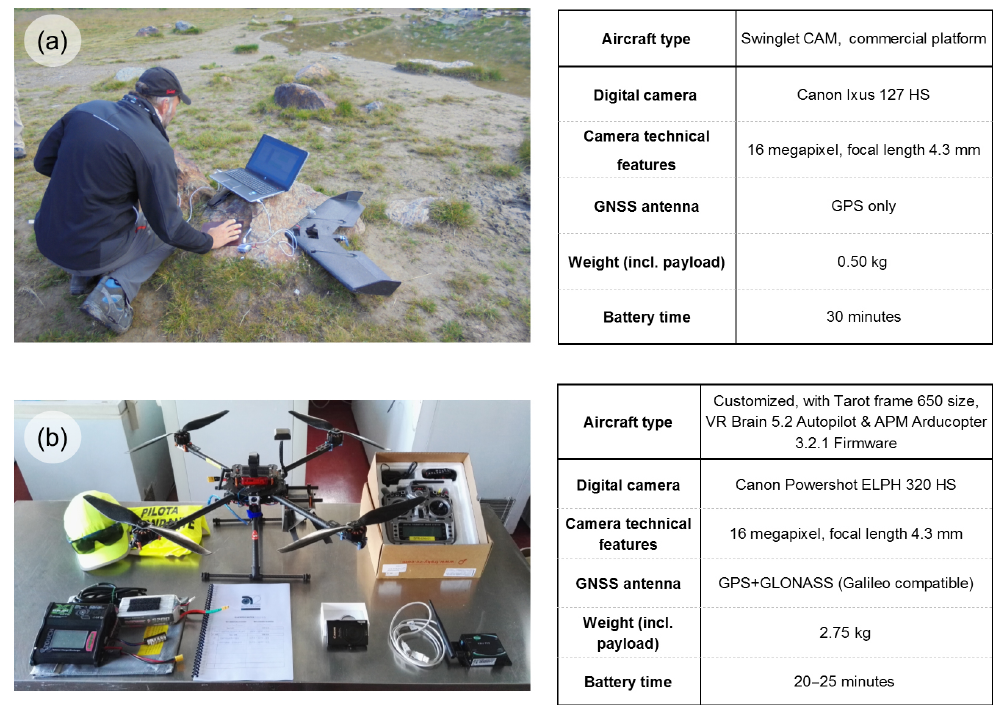
Figure 3. The UAVs used in surveys of the Forni Glacier and their characteristics. (a) The SwingletCam fixed-wing aircraft employed in 2014, at its take-off site by Lake Rosole; (b) the customized quadcopter used in 2016 in the